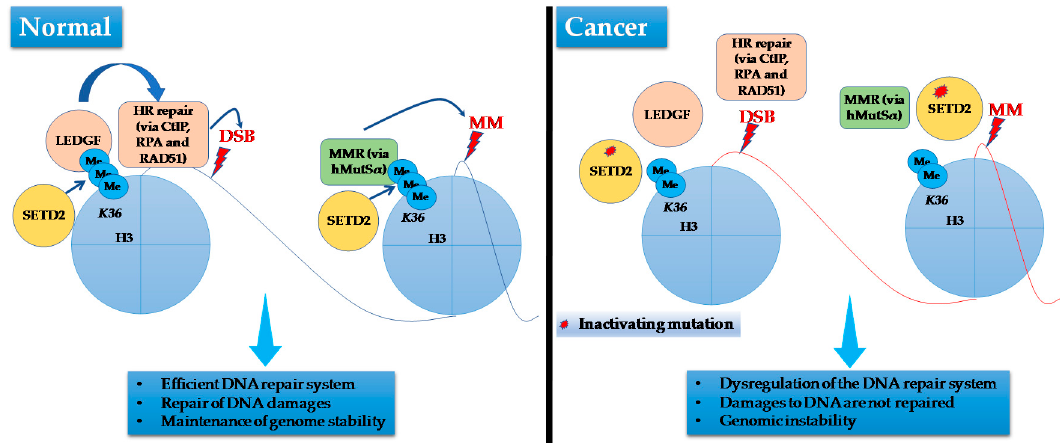
Figure 4. Trimethylation of H3K36 by SETD2 is required for function of DNA repair system via homologous recombination (HR) repair and mismatch repair (MMR). HR repair of DNA double-strand breaks (DSBs) occurs with the help of Lens epithelium-derived growth factor p75 (LEDGF) that binds to H3K36me3 and allows recruitment of C-terminal binding protein interacting protein (CtIP) to the DSB sites. This further allows Replication Protein A (RPA) and RAD51 binding to damaged sites. In addition, H3K36me3 contributes to MMR via recruiting the mismatch recognition protein hMutS α onto chromatin. SETD2 inactivation results in the global reduction of the histone mark H3K36me3. This leads to deficiency in DNA repair systems which in turn contributes to genome instability. Blue DNA lines means DNA is repaired while Red DNA lines means DNA is not repaired.